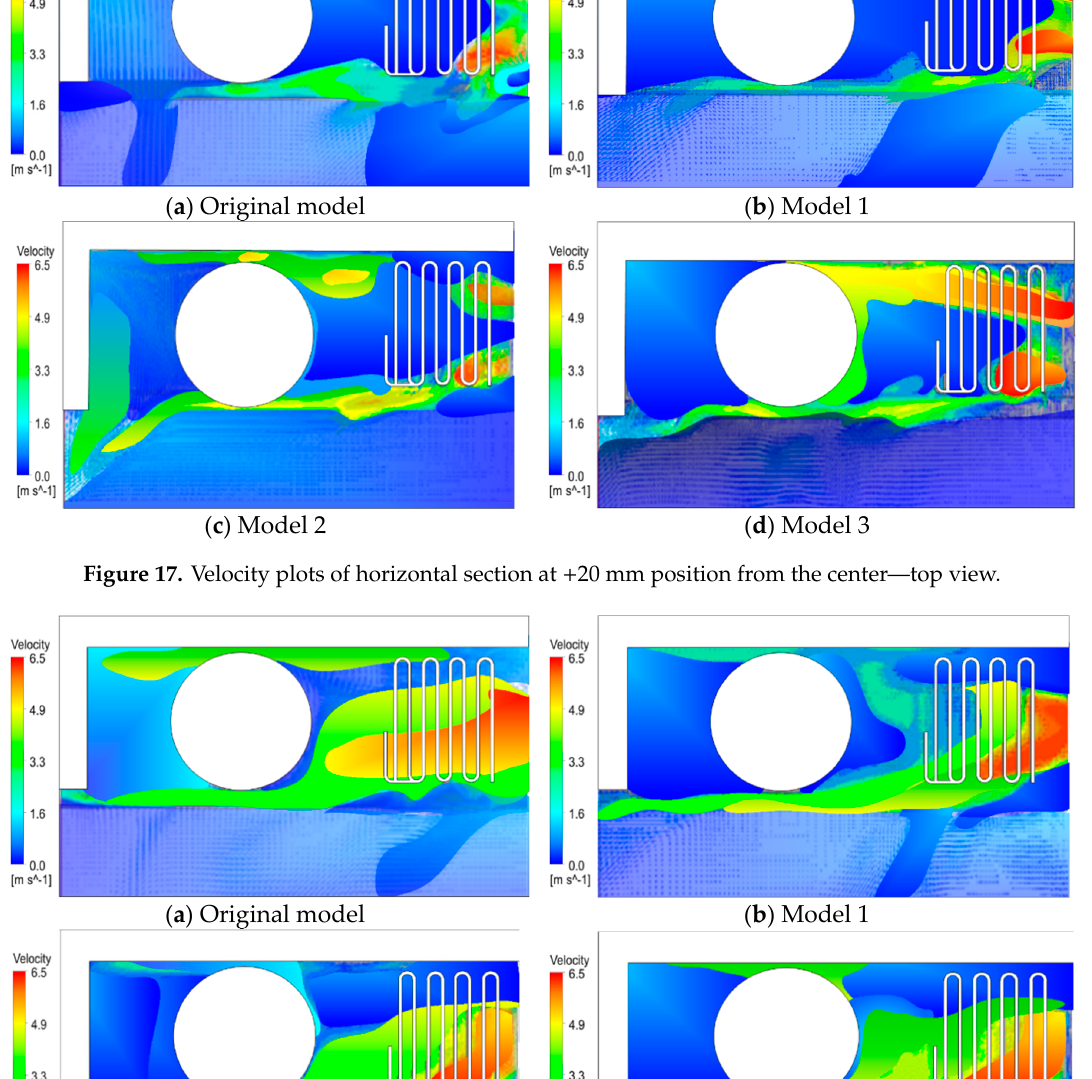
Figure 17. Velocity plots of horizontal section at +20 mm position from the center—top view.